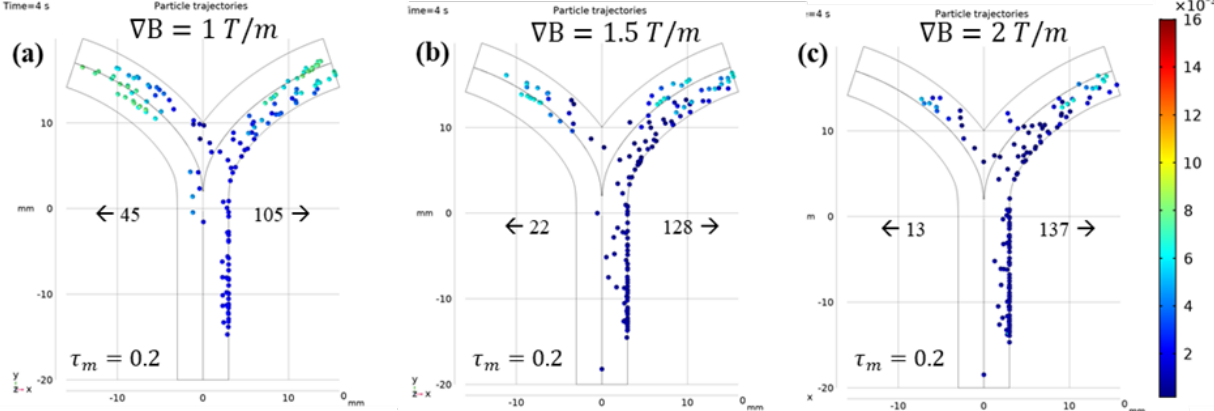
Figure 9. Microrobot trajectories with fixed 𝜏 𝑚 = 0.2 under the influence of different 𝛻𝐵 values: ( a ) 𝛻𝐵 = 1 T/m , ( b ) 𝛻𝐵 = 1.5 T/m , and ( c ) 𝛻𝐵 = 2 T/m .